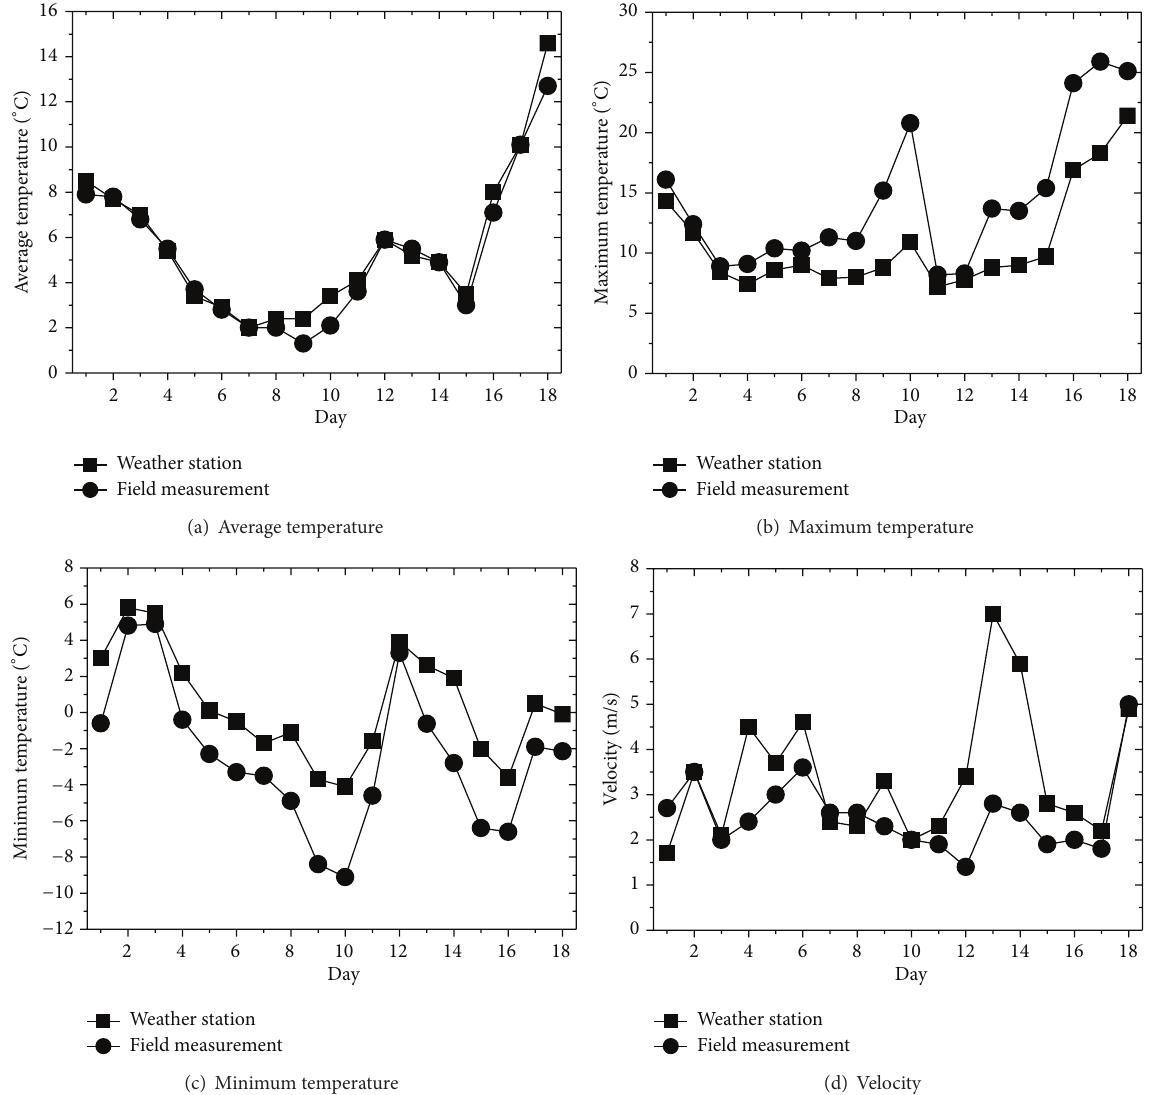
Figure 11: Wind velocity change according to wind angle change by measured points before and after construction of